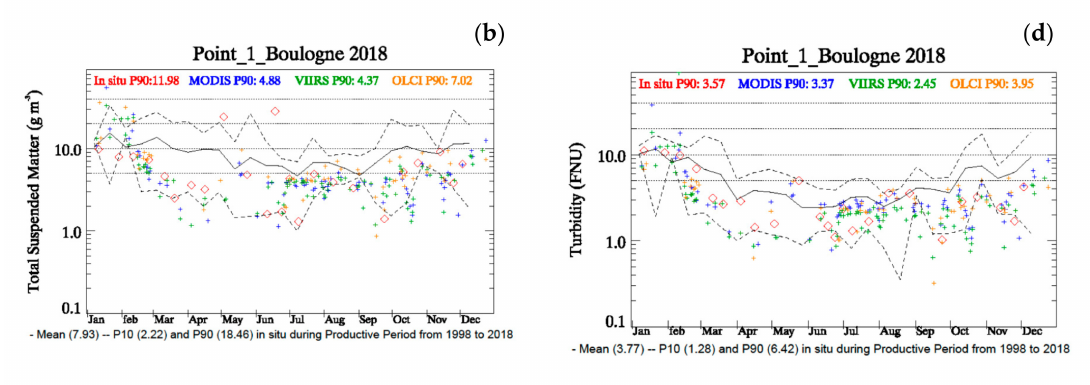
Figure 12. TSM ( a , b ) and Turbidity ( c , d ) at Boulogne Point 1 in 2016 and 2018.